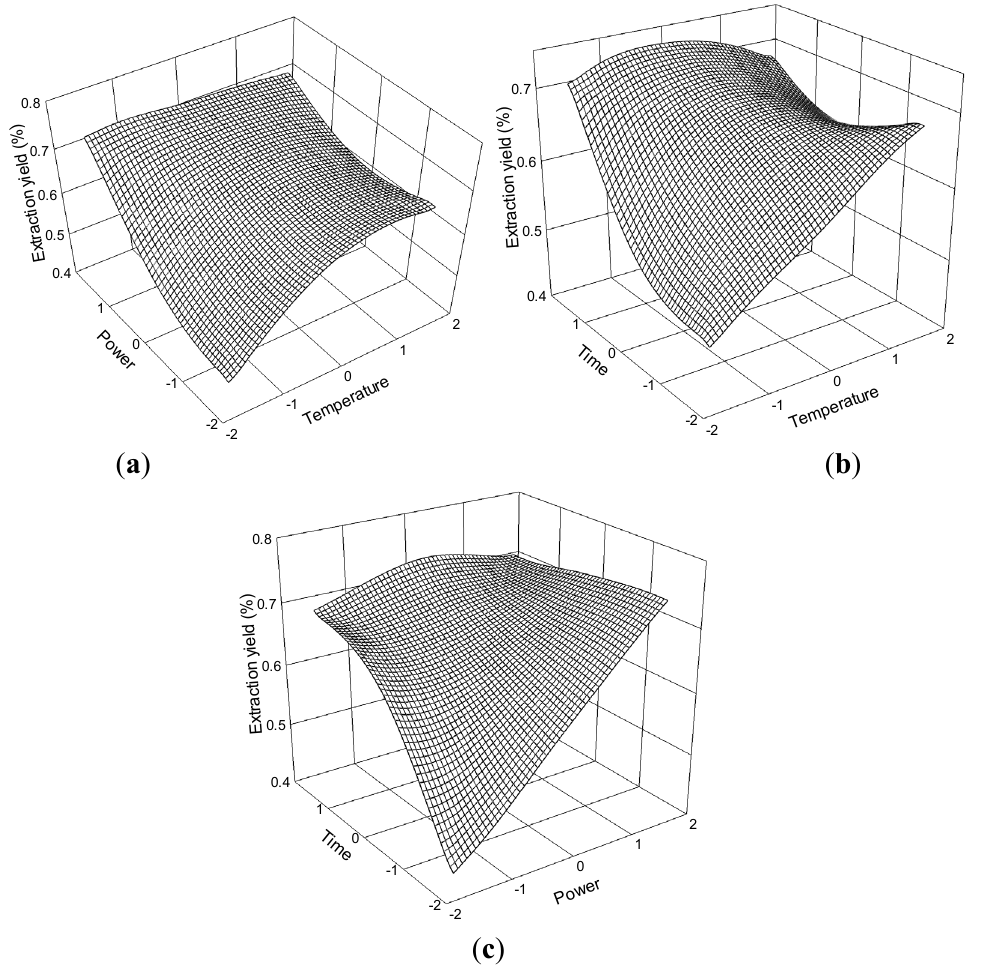
Figure 11. Response surface plots for the effects of ( a ) temperature/power ( b ) temperature/time ( c ) power/time on the extraction yield of senkyunolide